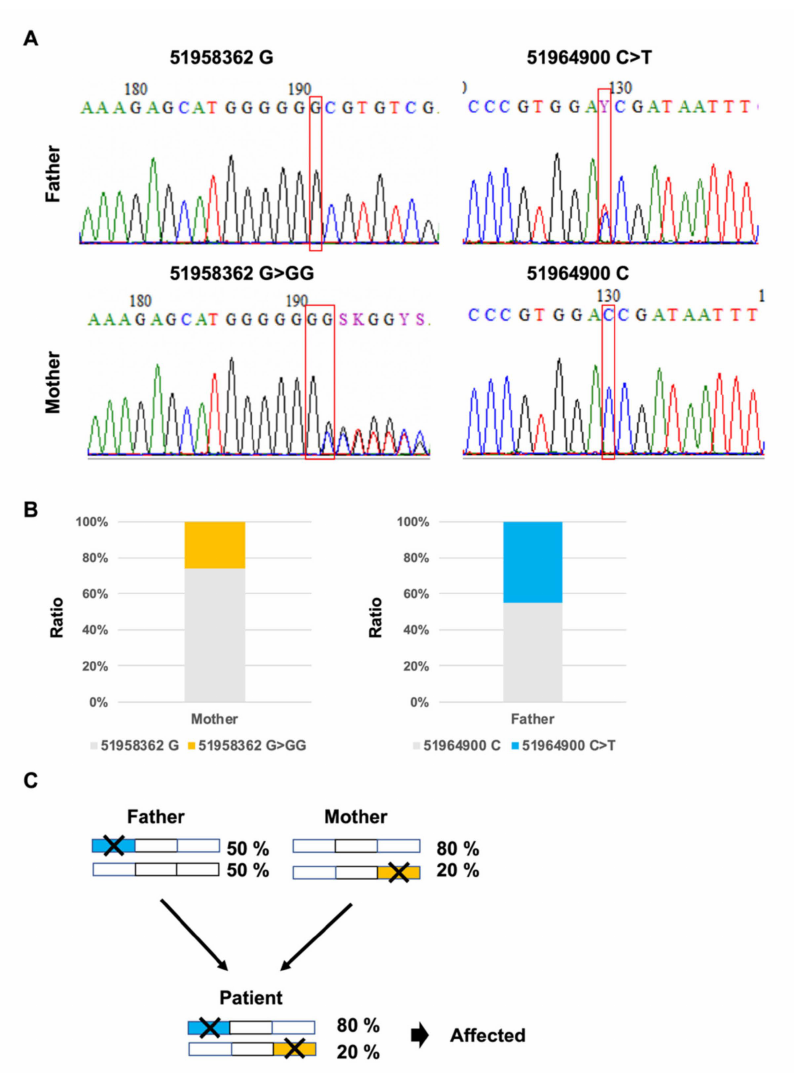
Figure 4. ( A ) Parent electropherograms of the ATP7B mutations loci by Sanger sequencing; ( B ) The expressed allele frequency of variants by targeted double-stranded cDNA-based sequenc- ing; ( C ) Predicted inheritance and disease modelling based on targeted double-stranded cDNA- based